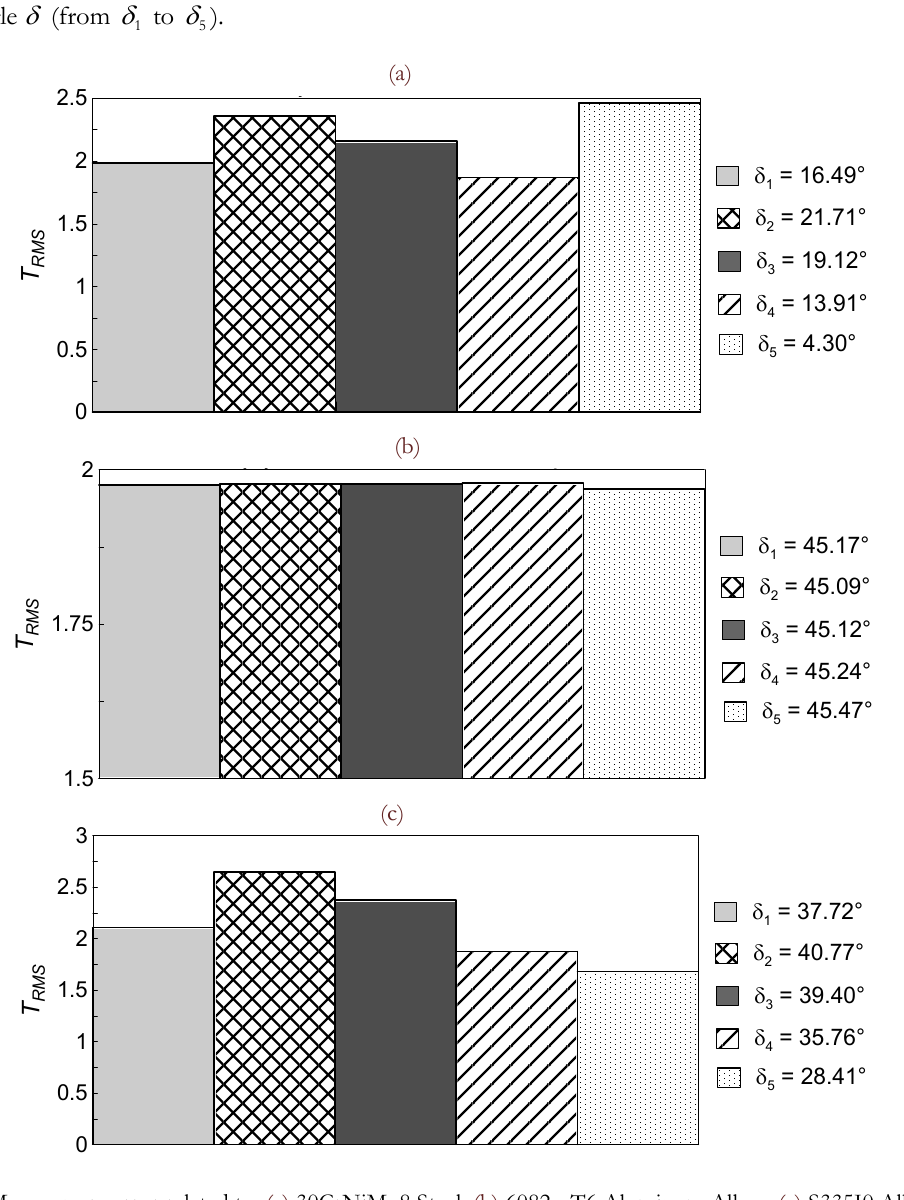
Figure 2: Mean square error related to: (a) 30CrNiMo8 Steel; (b) 6082 - T6 Aluminum Alloy ; (c) S335J0 Alloy